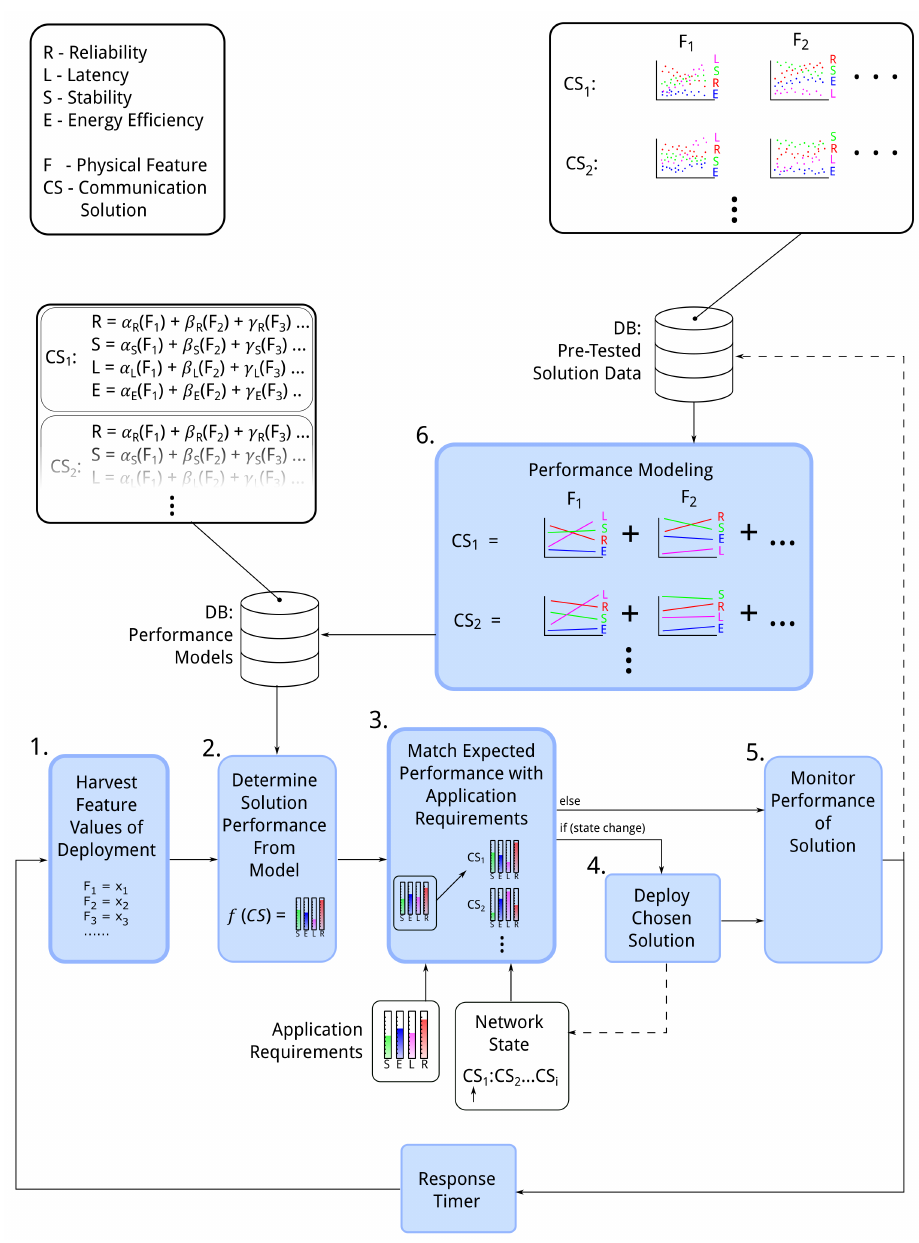
Figure 2. Functional block diagram showing the component relationships for the